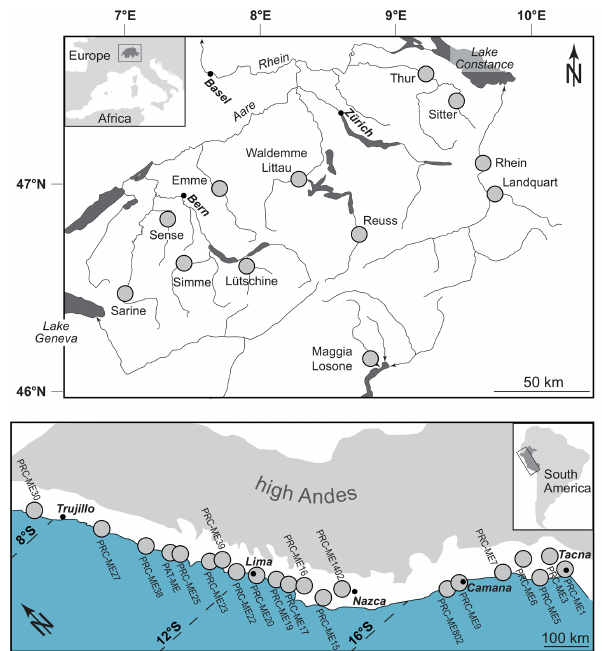
Figure 1. (A) Map showing the sites where grain size data have been measured in the Swiss Alps. The research sites are close to wa- ter gauging stations; (B) map showing locations for which grain size and water discharge data are available in Peru (Litty et al.,